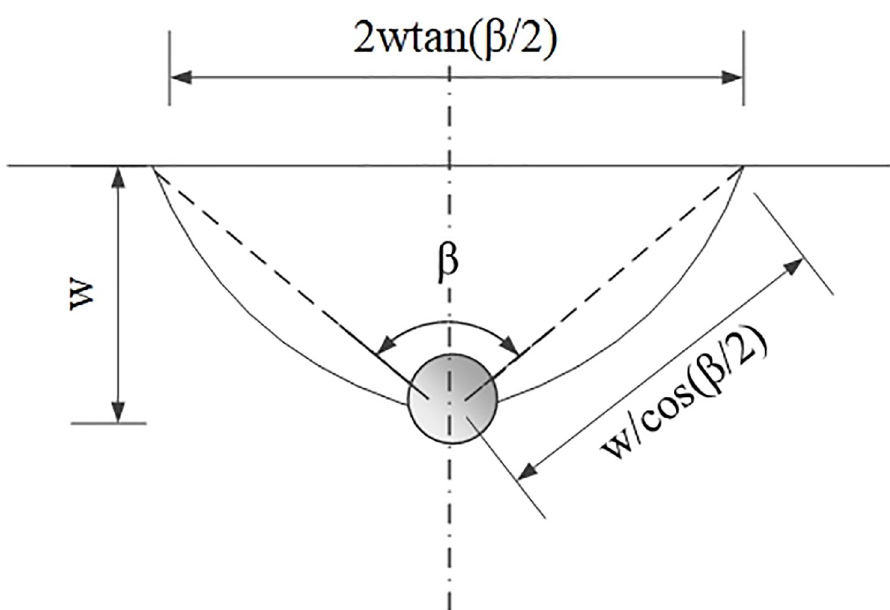
Fig 2. Single-hole blasting casting